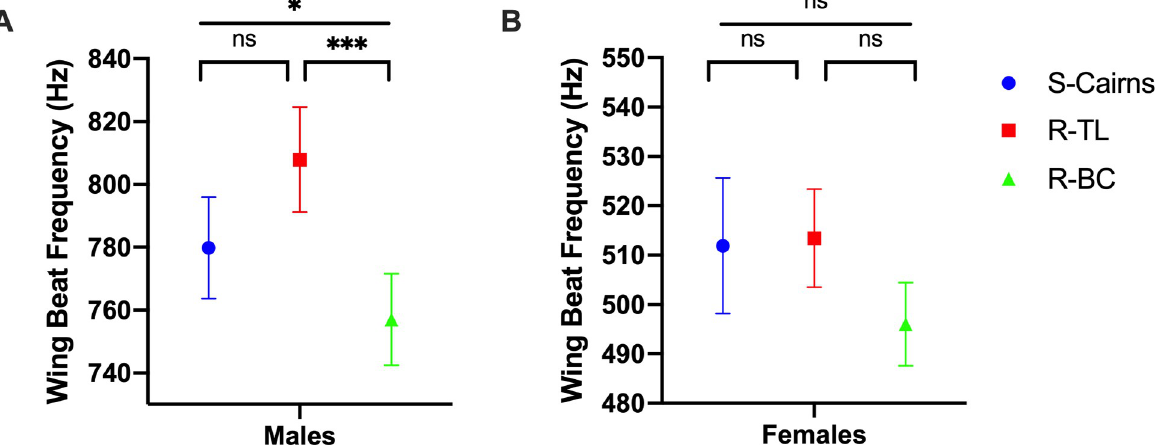
Fig 3. Wing Beat Frequency. Average wing beat frequencies recorded from (A) male and (B) female mosquitoes from S-Cairns, R-TL and R-BC strains (Mean ± 95% CI). ( � : P < 0.05, ��� : P <